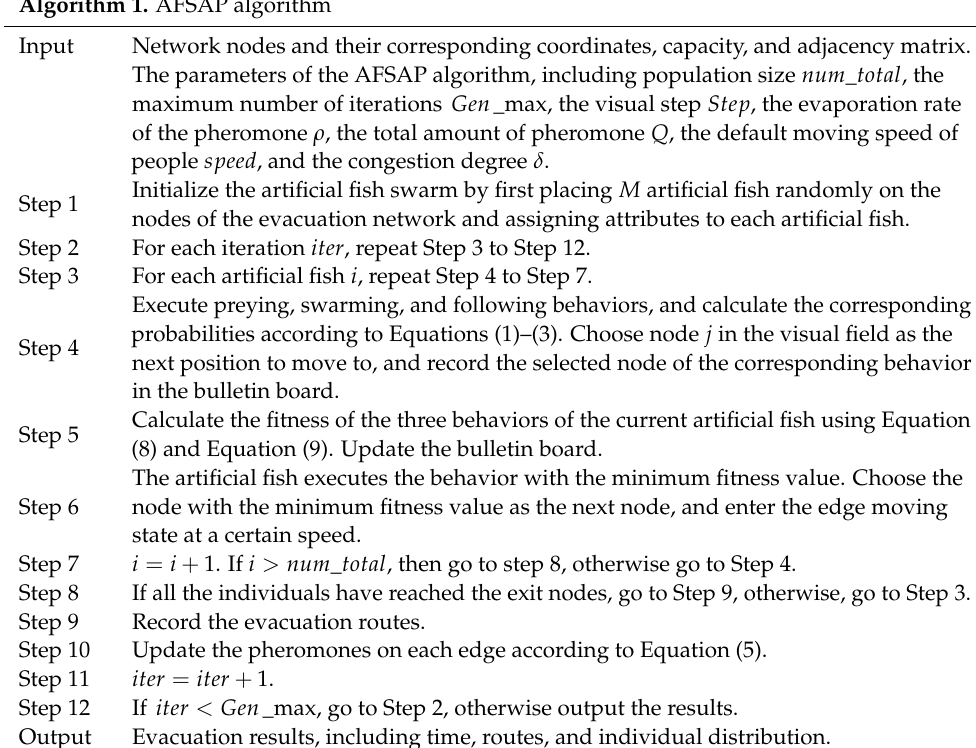
Algorithm 1. AFSAP